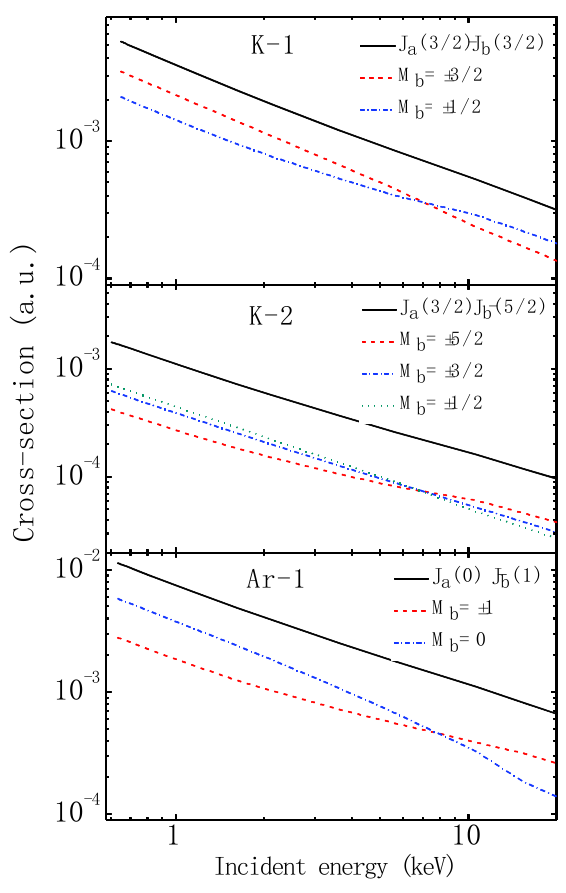
Figure 1. Electron-impact magnetic sublevel and total excitation cross-sections (in atomic units) for K-like and Ar-like tungsten ions as a function of incident electron